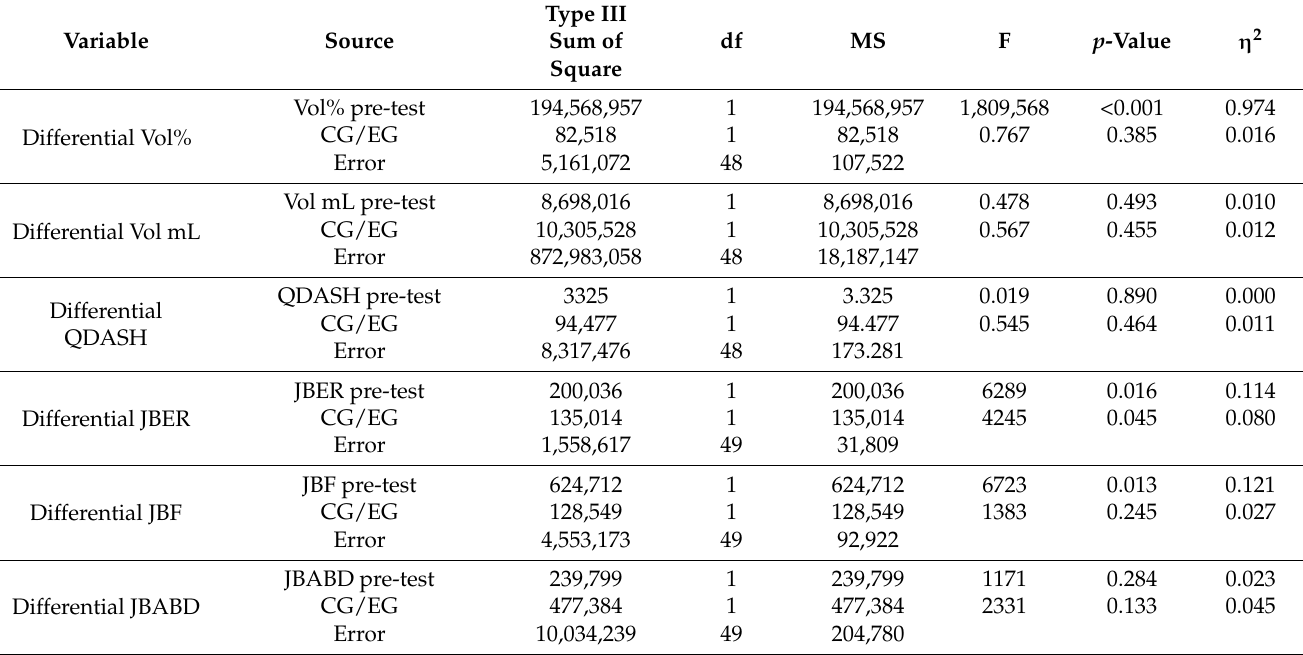
Table 2. Comparison between groups in continuous variables differential punctuation, controlling pretest scores.